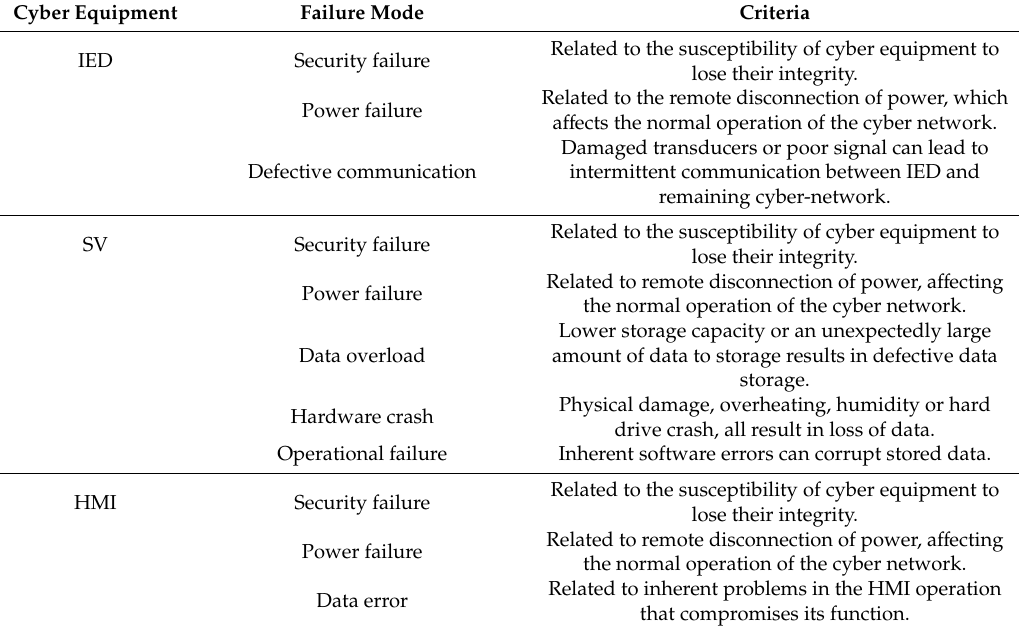
Table 8. Failure modes for cyber-control equipment considered for